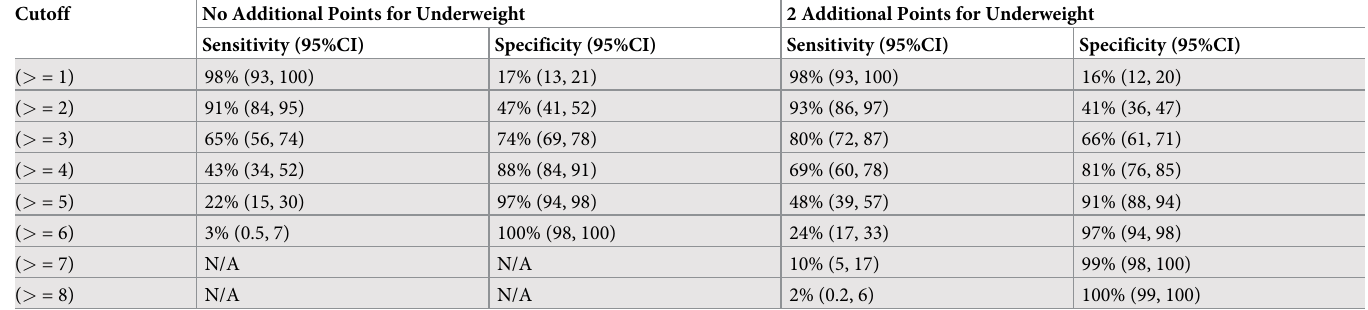
Table 3. Accuracy of number of TB symptoms (using two simple scoring systems) in predicting culture-positive TB among adult presumptive patients at four clin- ics in Kampala, Uganda. (n = 491, Prevalence = 12%).